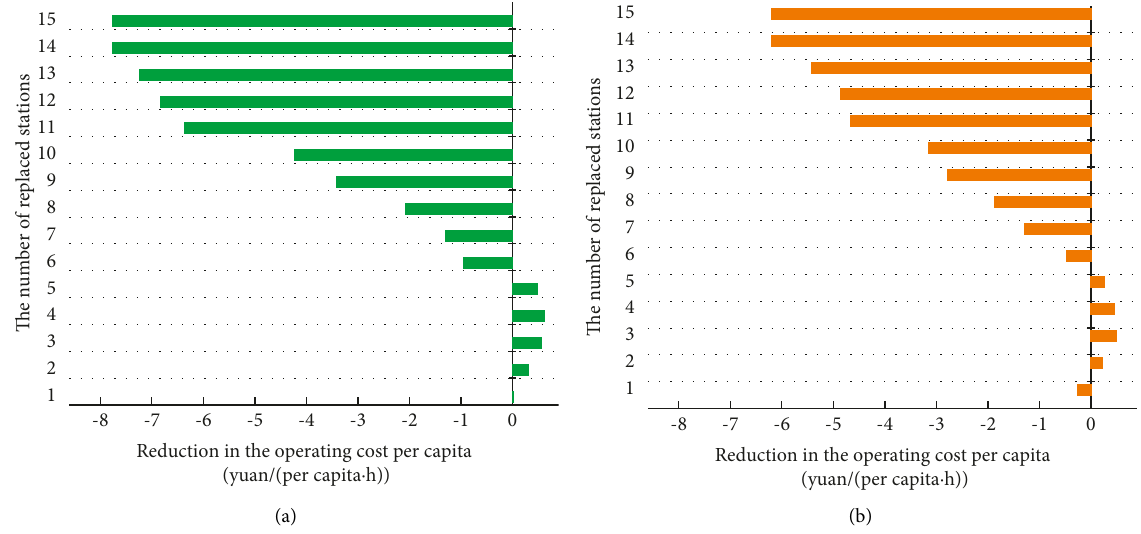
Figure 5: The reductions in the operating cost per capita in (a) integrated operation mode I and (b) integrated operation mode II.